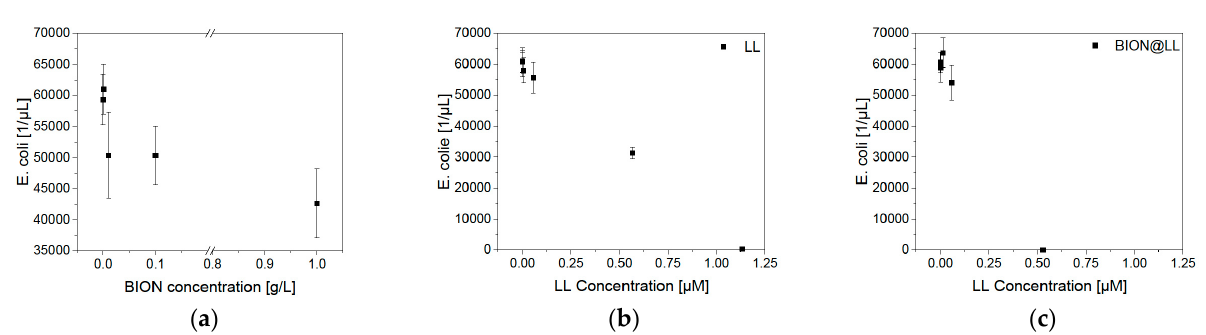
Figure 8. Growth of E. coli (BL21 (RH) 4 GFP expressing) in M9 medium under different ( a ) BION concentrations, ( b ) LL concentrations, and ( c ) amounts of the MNP@LL complex. Analysis with microscopy.